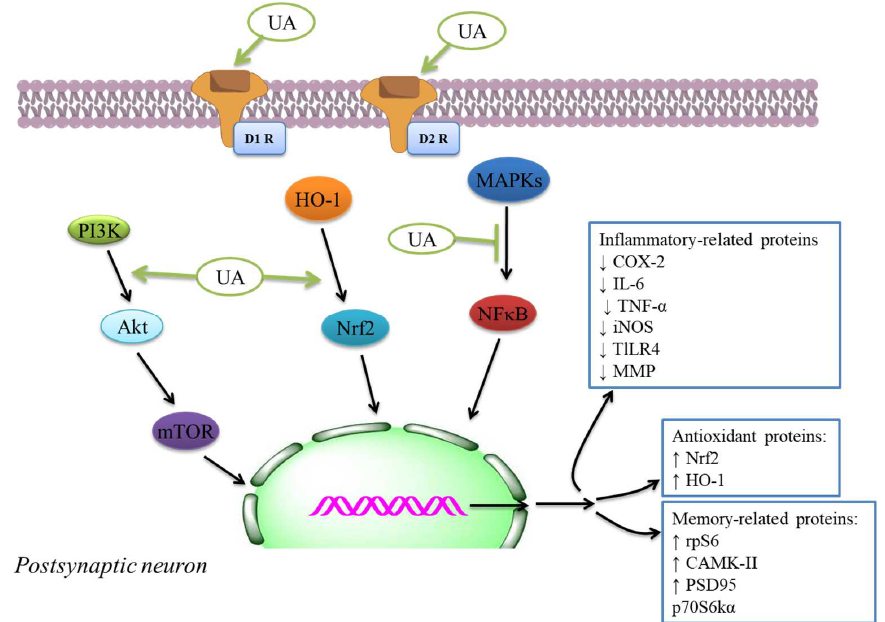
Figure 2. Descriptive proposal of the molecular targets altered through UA in a putative synapse. factor (erythroid-derived 2)-like 2/heme oxygenase 1 (Nrf2/HO-1) and PI3K/Akt/mTOR, that can inhibit MAPK/NF- κ B-mediated pathways. These intracellular pathways’ inflection can provide the expression of proteins involved in cognitive improvement and anti-oxidant and anti-inflammatory effects. D1R, dopamine receptor 1; D2R, dopamine receptor 2; ↓ , Decrease; ↑ , Increase.